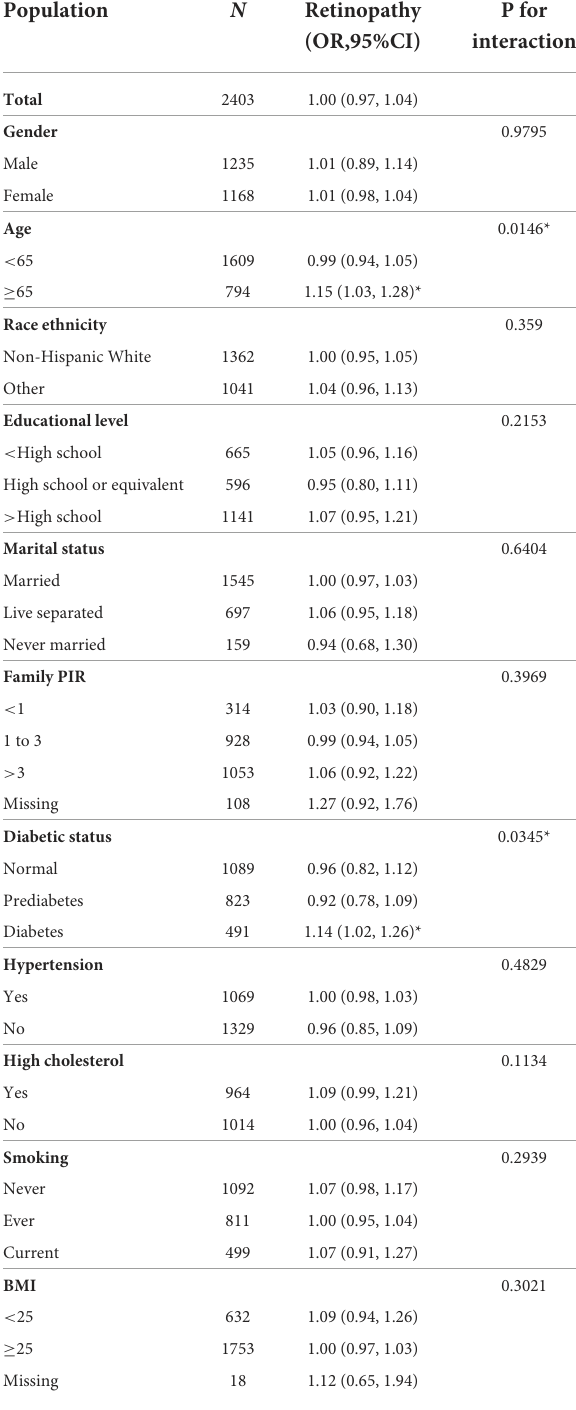
TABLE 2 The association between E-DII and retinopathy by different